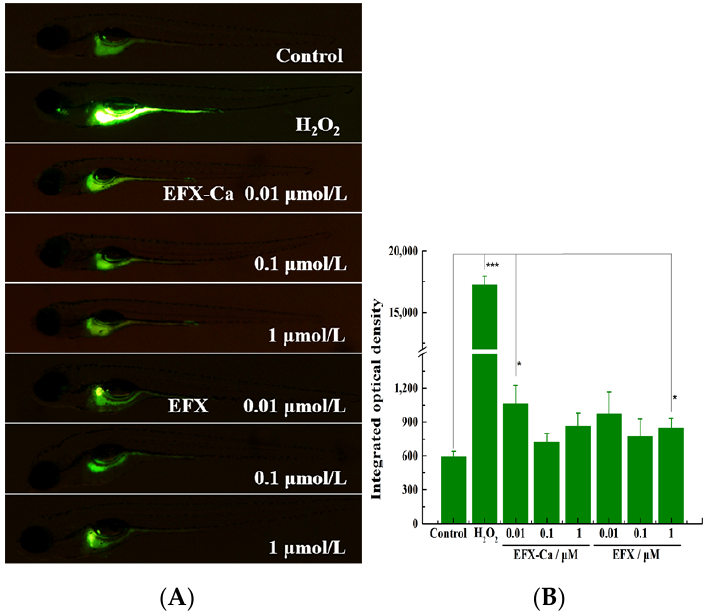
Figure 7. ( A ) The anti-inflammatory effect of EFX-Ca, compared with EFX at the same concentrations (0.01, 0.1, 1 μ M), on the H 2 O 2 -induced ROS production in zebrafish model, indicated by the green fluorescence probe and visualized by the added DCFH-DA. ( B ) The quantitative results for the oxidative stress in zebrafish, represented by the histogram on the right side, were statistically analyzed based on examining the integrated optical density (IOD) of the green fluorescence in the tested zebrafish. Mean ± SD: * P < 0.05, *** P < 0.001.